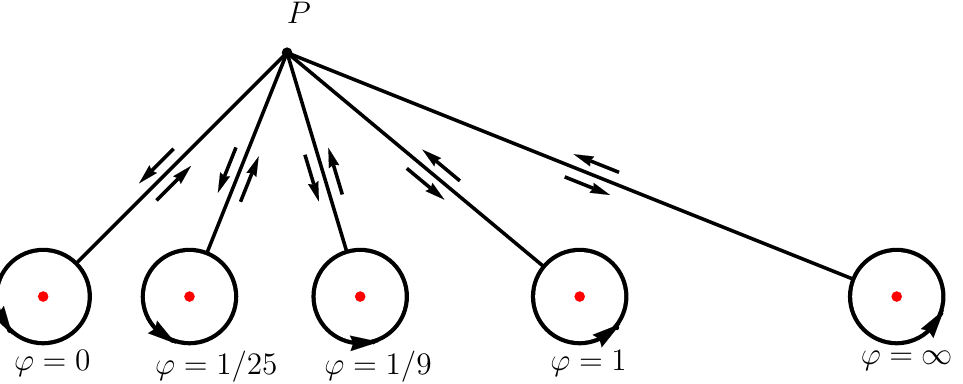
Figure 9 . A sketch of a contour, that can be deformed to a point, which shows that the product of all the monodromy matrices, taken in order, is the identity. In the (cid:12)gure, P is a basepoint for the